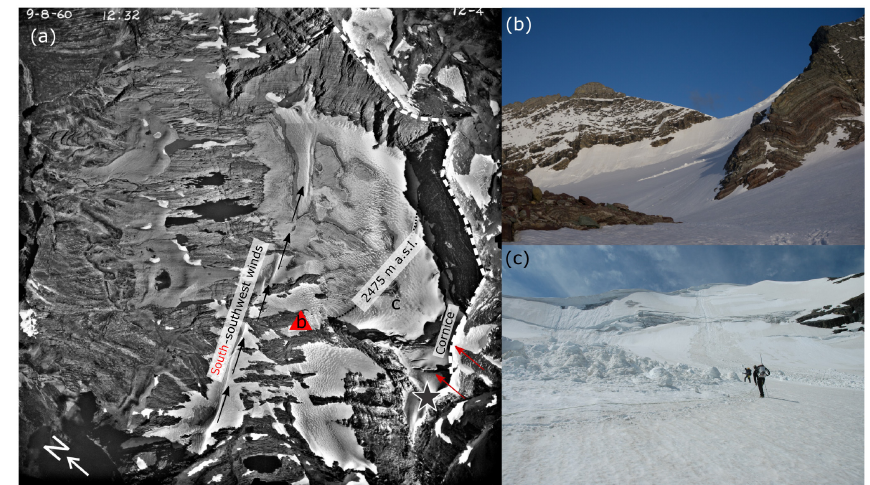
Figure 6. Snow avalanches and wind-drifted snow at Sperry Glacier. (a) Aerial photograph of Sperry Glacier taken on 8 September 1960 showing a prominent ridge of wind-drifted snow, which is evidence of southwest winds in the basin (black arrows), is shown. The cornice that is evidence of south winds (red arrows) is labeled. Sperry Glacier meteorological station is shown (red triangle), and the approximate elevation (2475ma.s.l.) above which the winter and summer mass balance gradients change is drawn. The photograph also shows the glacier lapping over the top of Gunsight Peak (black star) at the highest elevation of the ridge (dotted white line). Photograph credit: USGS Climate Change in Mountain Ecosystem photograph archives. (b) Sperry Glacier in June 2010. Snow sluffing and loose avalanches off the headwall are depicted. Photograph was taken from the Sperry Glacier meteorological station, labeled “b” in (a) . Photograph credit: Joel Harper. (c) Sperry Glacier in June 2006. Cornice collapse (on the left) often causes a localized slab avalanche. Loose avalanche depicted on the right. Photograph credit: USGS Climate Change in Mountain Ecosystem photograph archives. Photograph was taken from the approximate location labeled “c” in (a)